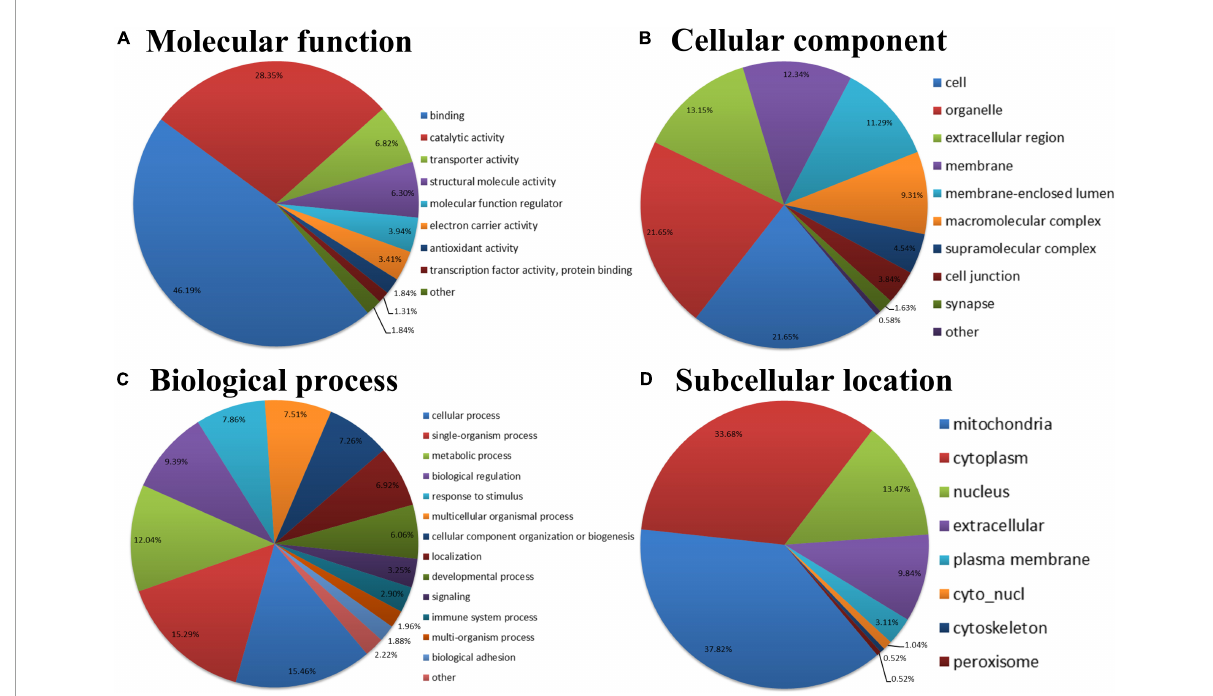
FIGURE3 GO and subcellular location annotation classification of the AF/SR differentially expressed acetylated proteome in LAA tissues. (A) Molecular function. (B) Cellular component. (C) Biological process. (D) Subcellular location. GO, gene ontology; AF, atrial fibrillation; SR, sinus rhythm; LAA, left atrial